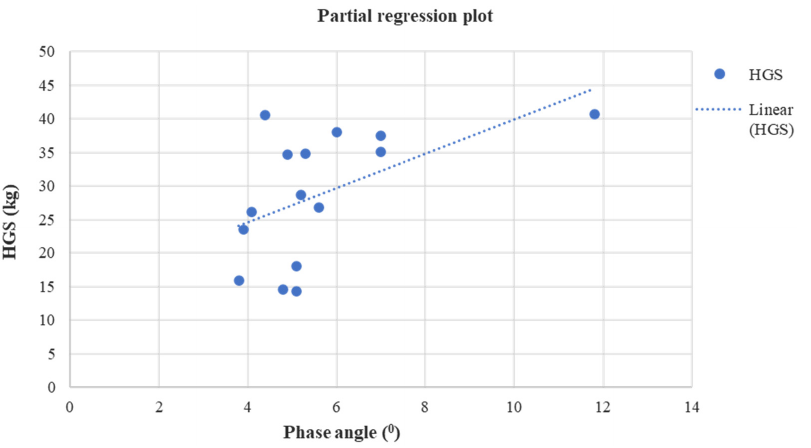
Figure 3. Linear regression analysis between the HGS (kg) and PhA ( 0 ) after four months in group A ( r = 0.52, p = 0.04).